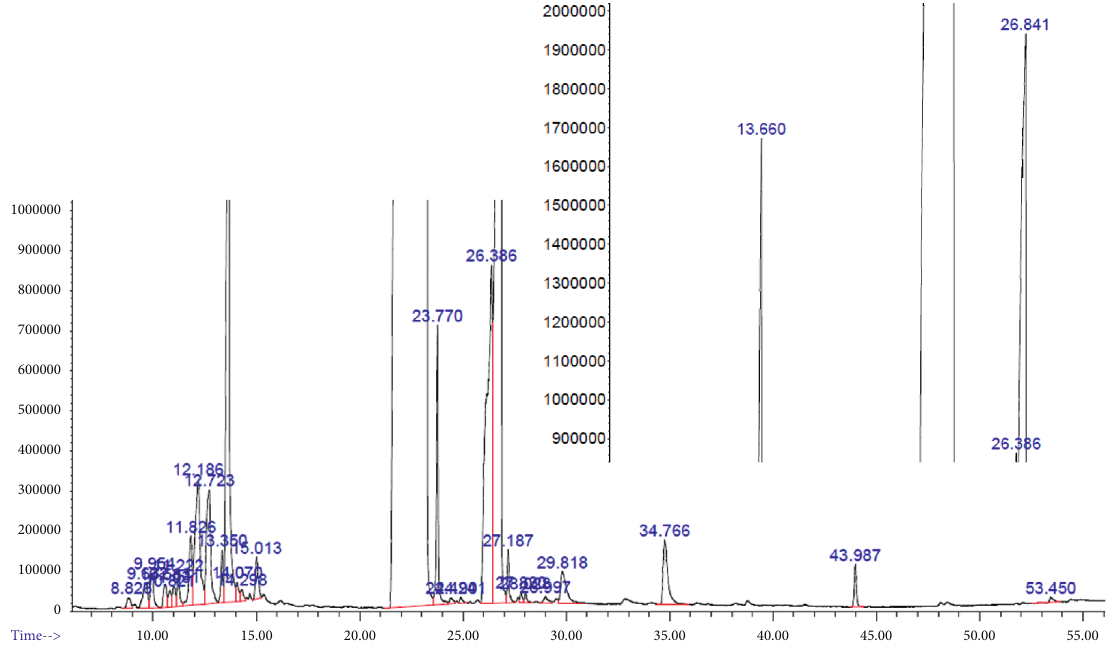
Figure 2: Chromatogram of the compounds present in the ethanol extract of Mammea Americana